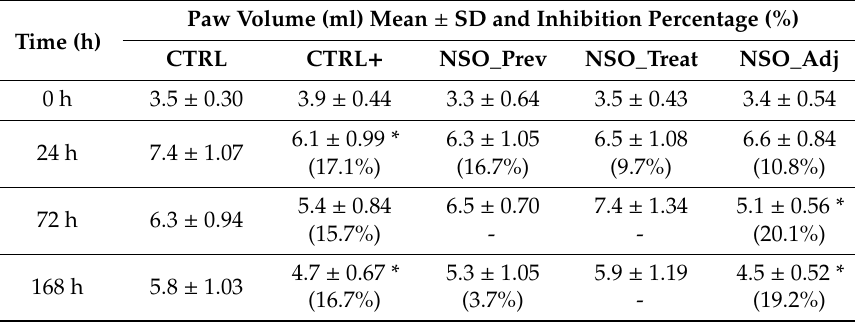
Table 6. Anti-inflammatory e ff ect of NSO on sub-acute inflammation.